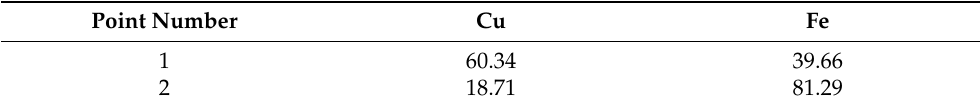
Table 6. EDS point results for the Cu–Fe interface in Figure 4b area A (at.%). Point Number